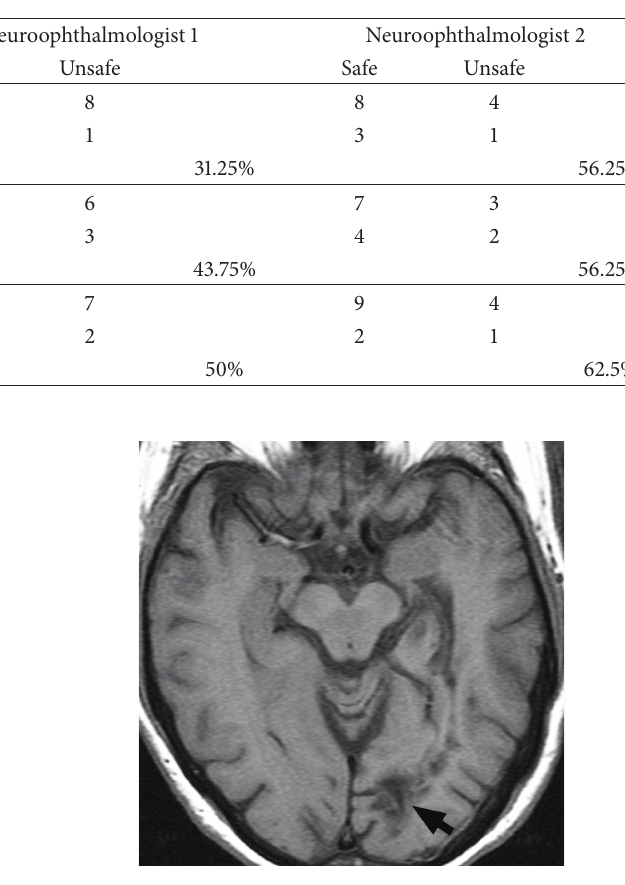
Figure 1: Axial T2 MRI demonstrates a large left parietooccipital arteriovenous malformation yet the patient was found to be a safe driver.